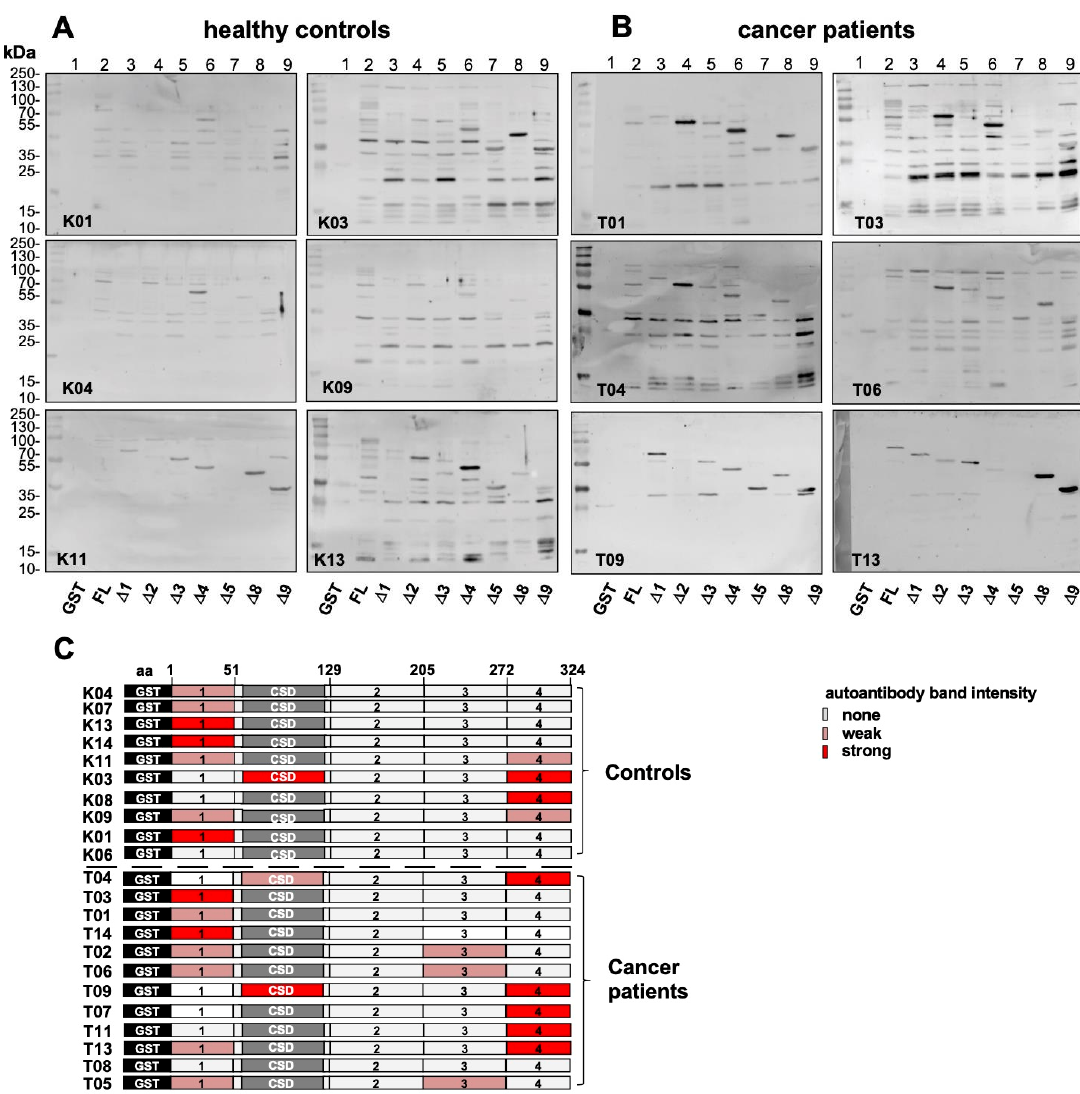
Figure 5. Epitope mapping with abbreviated YB-1 protein constructs. GST-tagged YB-1 proteins from Figure 2A were separated by SDS-PAGE and probed with serum samples from healthy controls and cancer patients as “primary” antibodies. Anti-human IgG Fc antibodies were added as the secondary antibody, followed by visualization with a tertiary anti-mouse antibody. ( A , B ) Six representative serum samples from the healthy controls and cancer patients are shown. In most samples’ autoantibodies against GST-YB-1 fusion proteins were visualized, however to a di ff erent extent in the two cohorts. In cancer patients, the band intensities seem stronger and the most prominent band detection is seen with constructs ∆ 2, ∆ 4, ∆ 8, and ∆ 9 (compare lanes 4, 6, 8, and 9 with other lanes). ( C ) Summary of all tested individuals. Controls (above) and cancer patients (below) are presented with their minimum autoantibody epitopes based on GST-YB-1 abbreviated protein construct blots. Signal of detected fragments are depicted in none ( < 10 M), weak (10–20 M), and strong ( > 20 M). For densitometry, readings compare with Table S3.